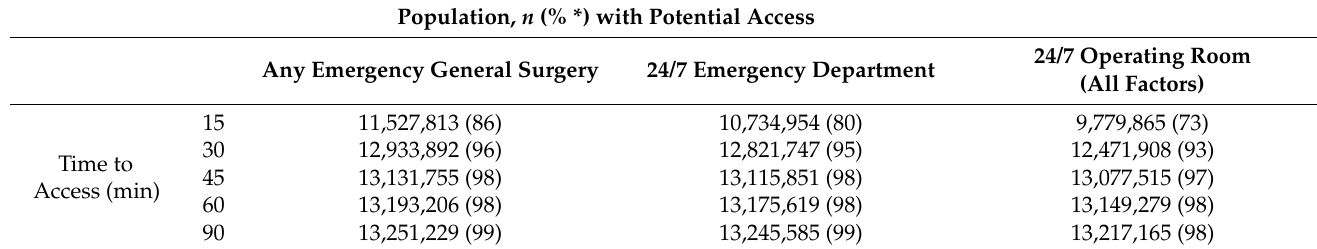
Table 1. Overall population with potential access to each type of care at varied driving time intervals.